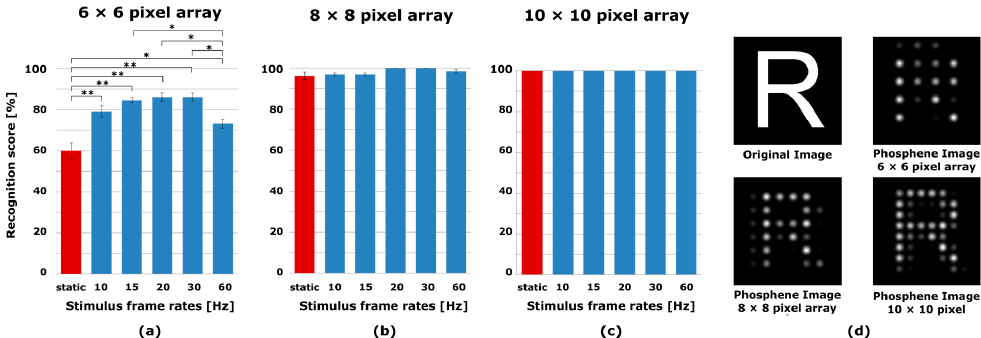
Figure 2. The recognition scores of English letters for 6 × 6, 8 × 8 and 10 × 10 pixel arrays and the example of original and phosphene images. The spatiotemporal pixelization method (blue) was compared with the static pixelization method (red). The result of the recognition score with the ( a ) 6 × 6; ( b ) 8 × 8; and ( c ) 10 × 10 pixel arrays are presented; ( d ) The example of original and phosphene images. Error bars indicate SEM. One-way ANOVA and Tukey post-hoc test, * p < 0.05, ** p < 0.01.